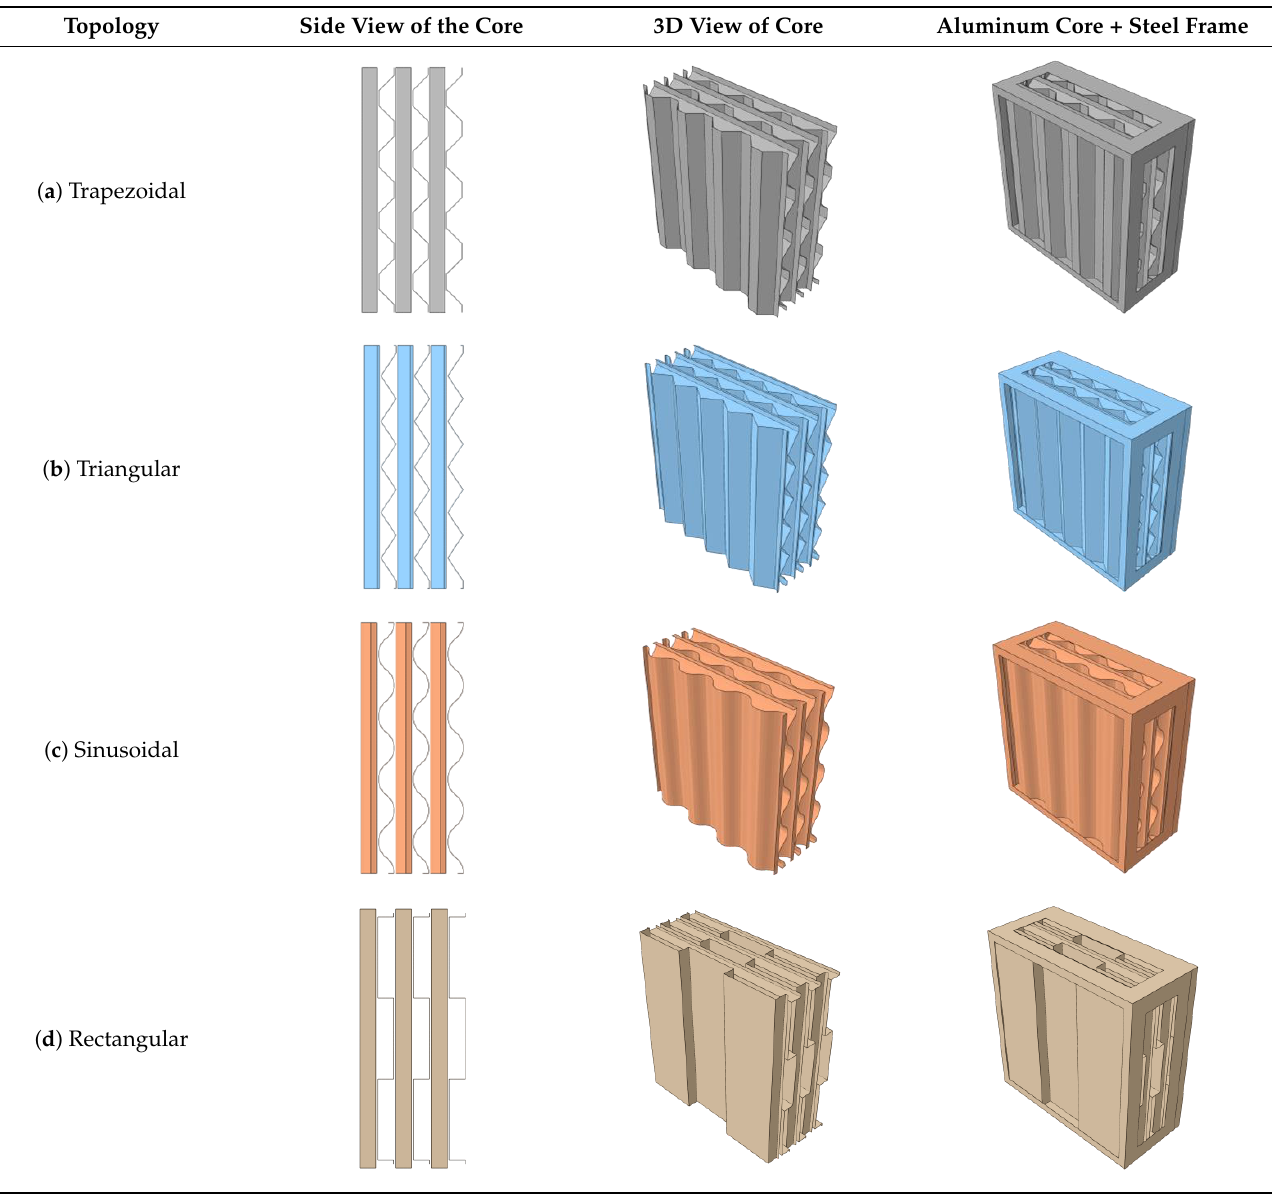
Table 1. Side and 3D views of the six corrugated layers composing the aluminium cores of different topologies, positioned in a steel frame. ( a ) Trapezoidal; ( b ) Triangular; ( c ) Sinusoidal; ( d ) Rectangular.